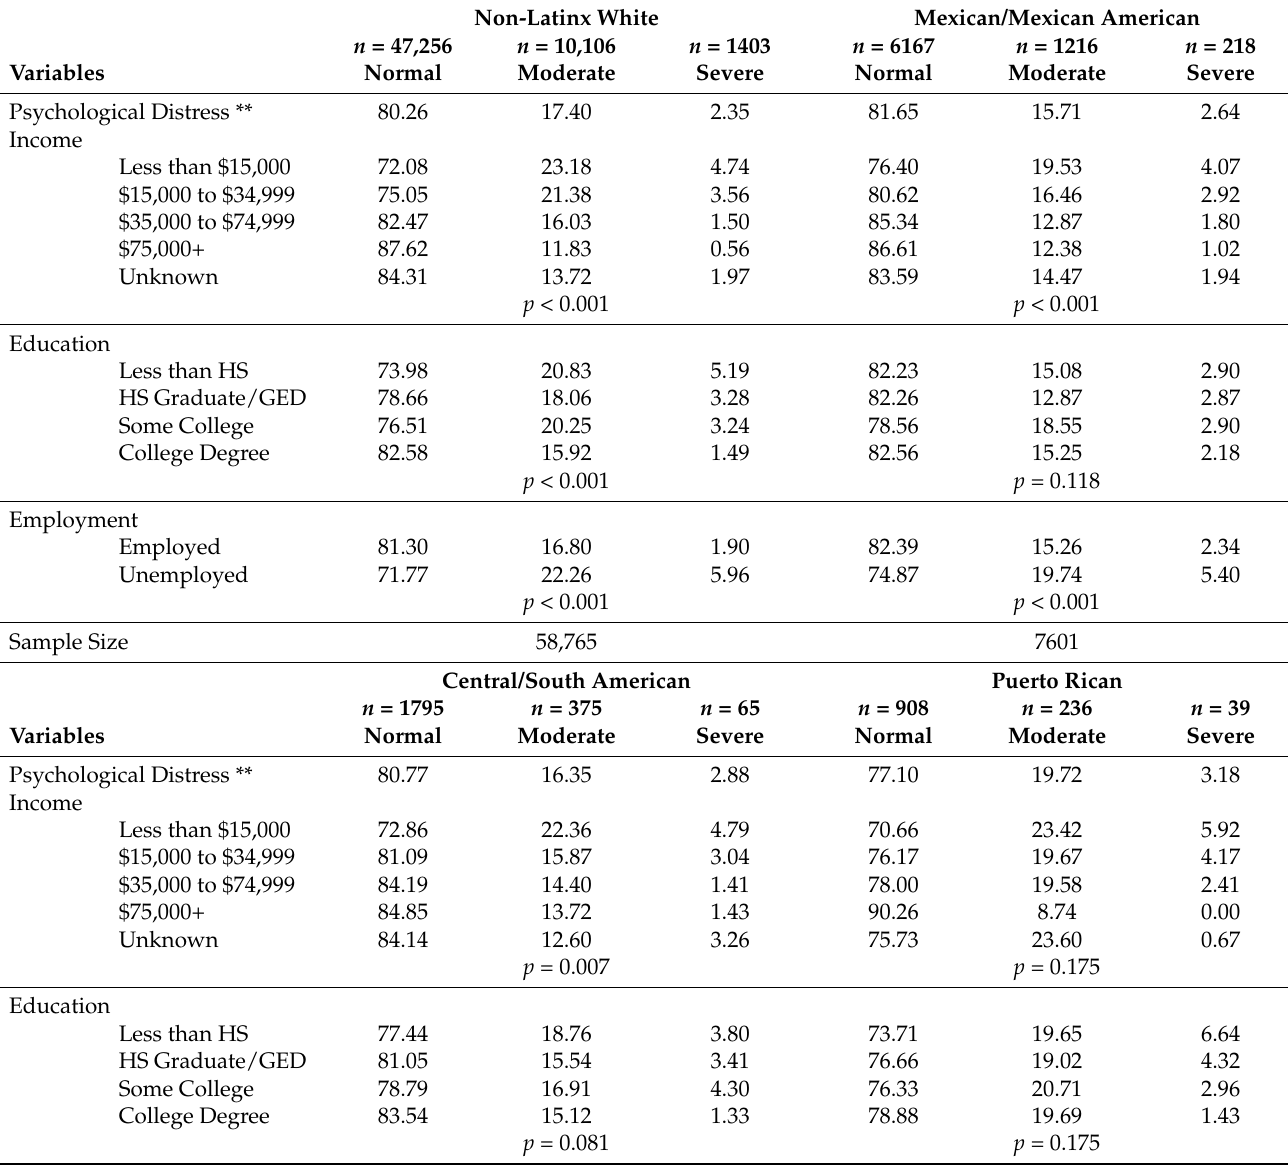
Table 3. Psychological Distress by Income, Education, and Employment among Latinx Subgroups and non-Latinx